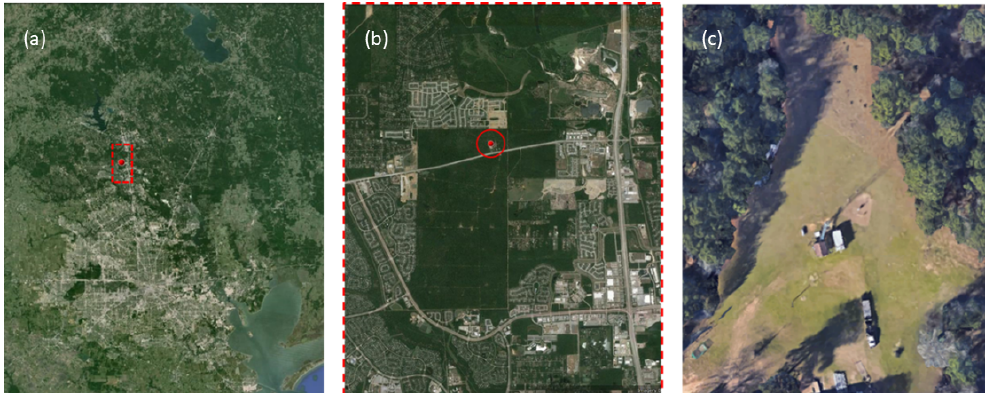
Figure 4. Satellite images of the WG Jones State Forest (JSF) site at which the field study was conducted. The location of JSF relative to Houston is shown in (a) , the location of the field site within the nearly rectangular JSF in (b) , and the clearing at which the chambers and instrument trailers were located in (c) . Map data © Google Earth 2017.